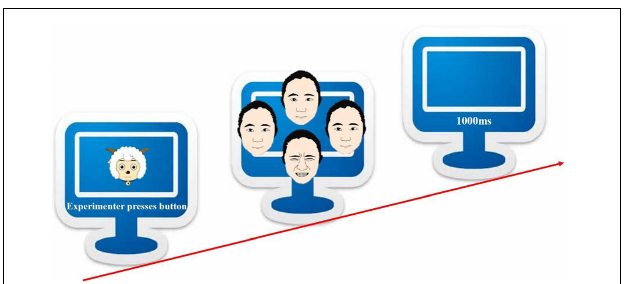
FIGURE 2 | Odd-one-out schematic diagram.